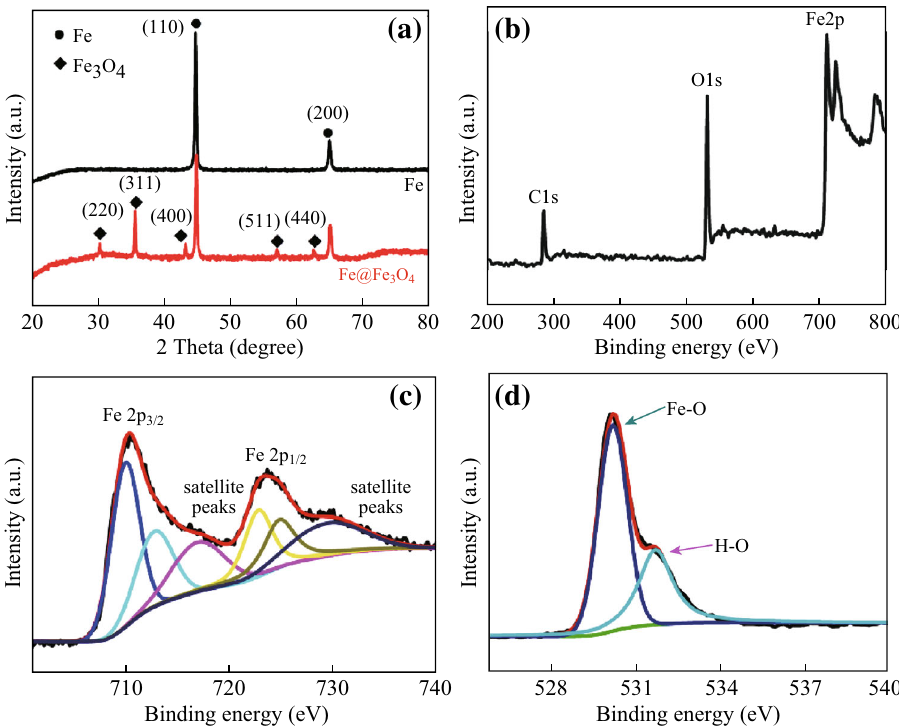
Fig. 3 a XRD patterns of Fe and Fe@Fe 3 O 4 . b XPS fully scanned spectra, high-resolution XPS spectrum of c Fe 2p and d O 1 s of Fe 3 O 4 scratched from